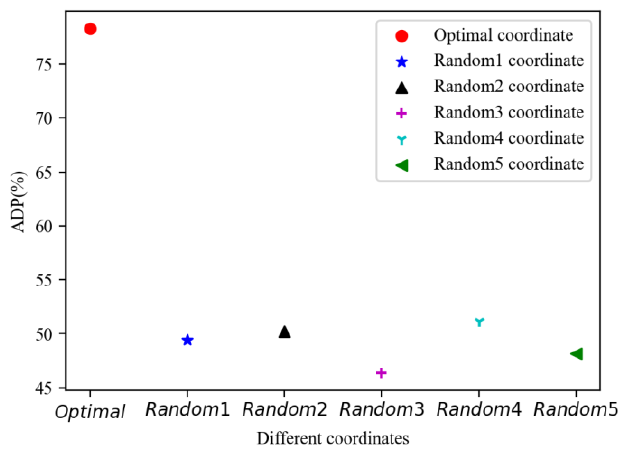
Figure 6. Comparison of the different patch’s coordinates. The “Random n” in the horizontal axis represents datasets labeled with different random coordinates, and “Optimal” represents the dataset labeled using our algorithm.